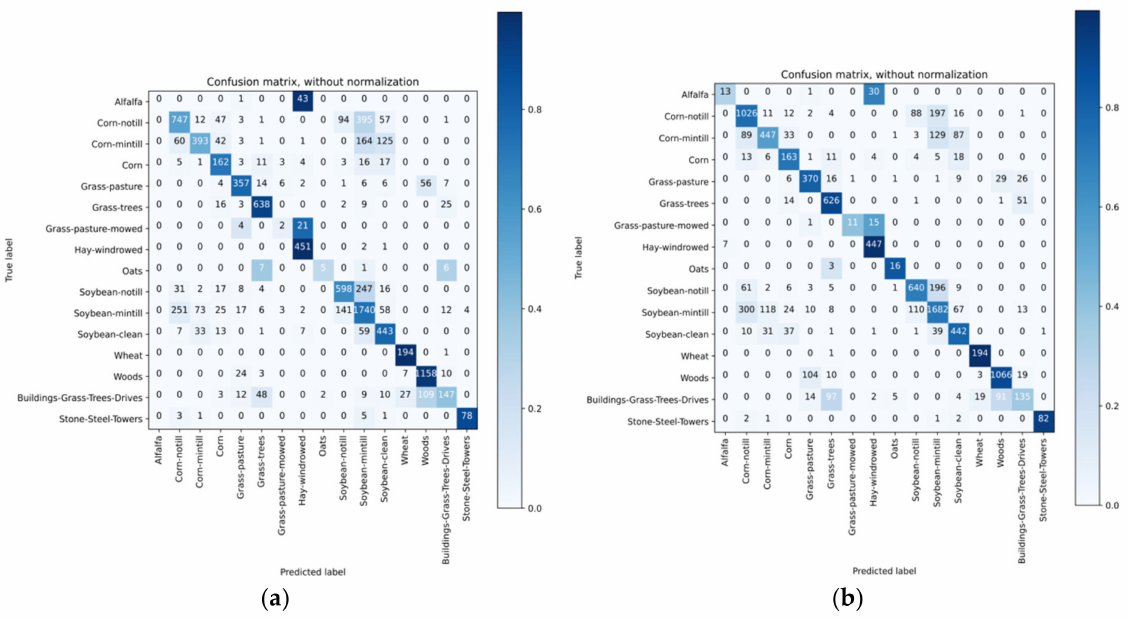
Figure 9. Comparison of confusion matrix under Indian Pines 5% training data: ( a ) CNN spe ( b ) CNN SFMF .